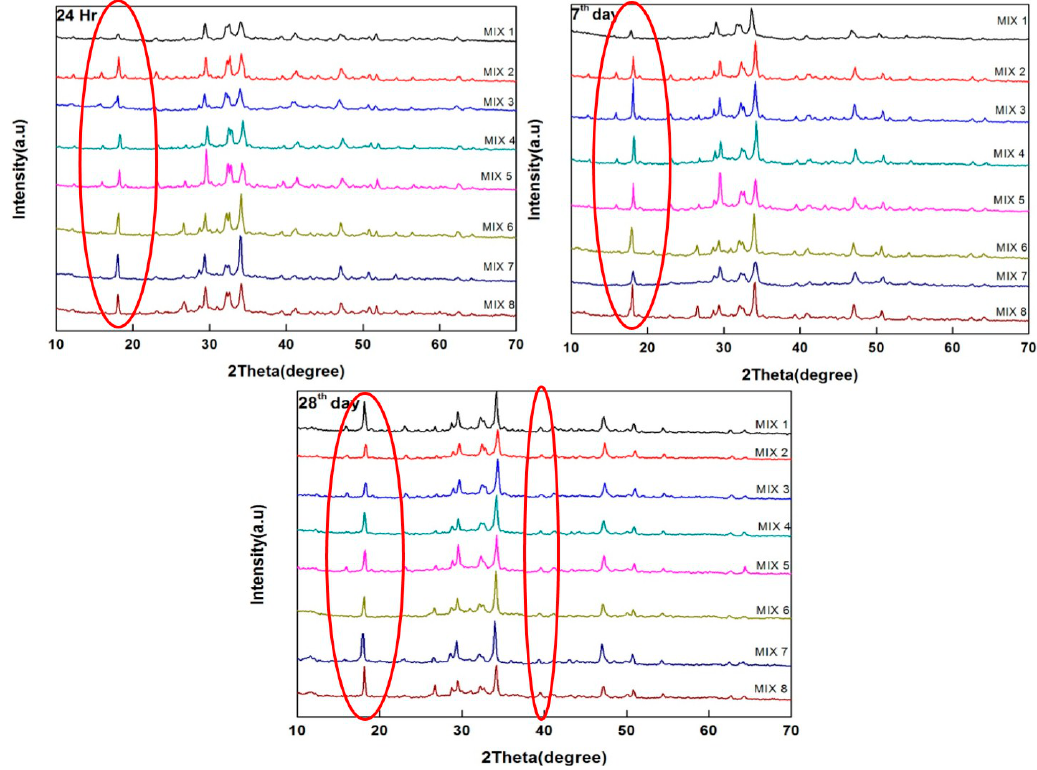
Figure 3. X-ray diffraction (XRD) spectra of all Mixes during various hydration intervals.